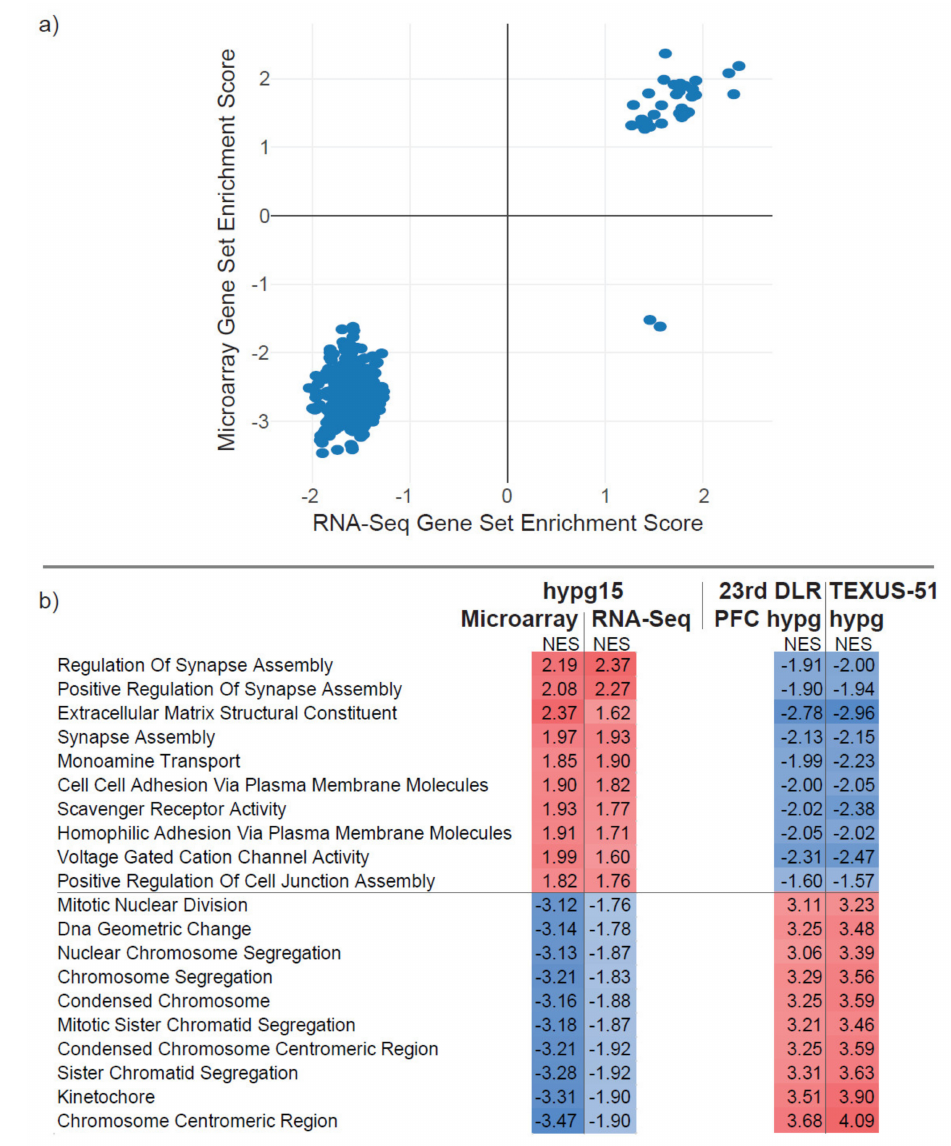
Figure 9. Gene set enrichment analysis. ( a ) Gene set enrichment analysis of all gene ontology gene sets for both technologies. Normalized enrichment scores (NES) for both data sets are plotted for all sets that showed significant enrichment in both technologies. The two contradictory outlier sets are “Regulation of small GTPase-mediated signal transduction” and “IRE1-mediated unfolded protein response”. ( b ) Top 10 gene sets with highest average positive NES and top 10 sets with highest average negative NES. The enrichment values for the two external hypergravity sets are given. All listed sets are significantly enriched for all